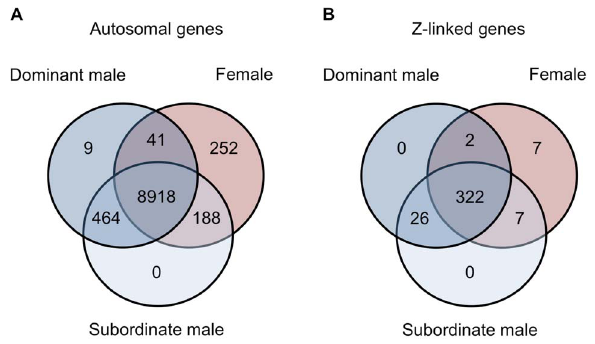
Figure 5. Genes shared between morphs. Venn diagrams for the number of autosomal (panel A) and Z-linked (panel B) genes expressed in females (red), subordinate males (light blue) and dominant males (dark